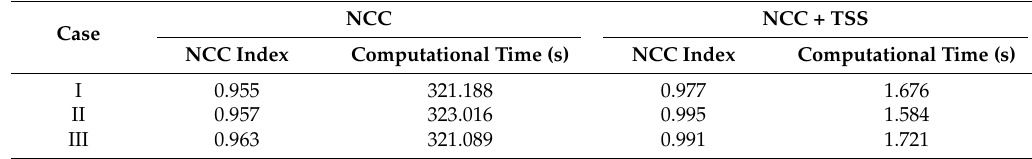
Table 4. NCC indices and computational time of image registration.